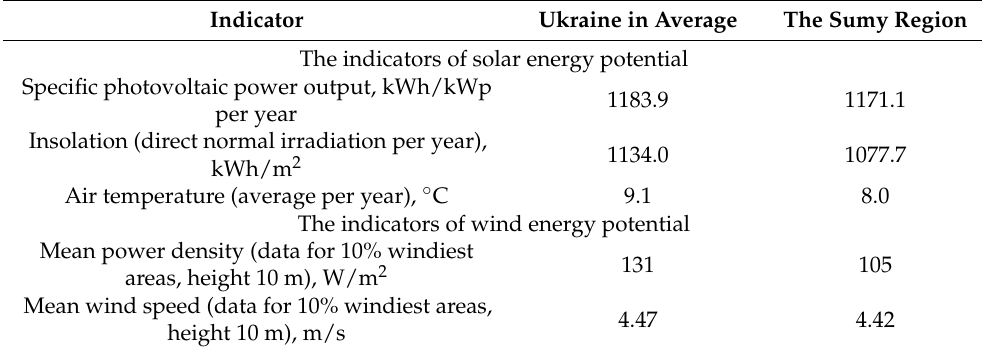
Table 3. Indicators of solar and wind potential of Ukraine and the Sumy region (compiled by the authors according to [57,58]).